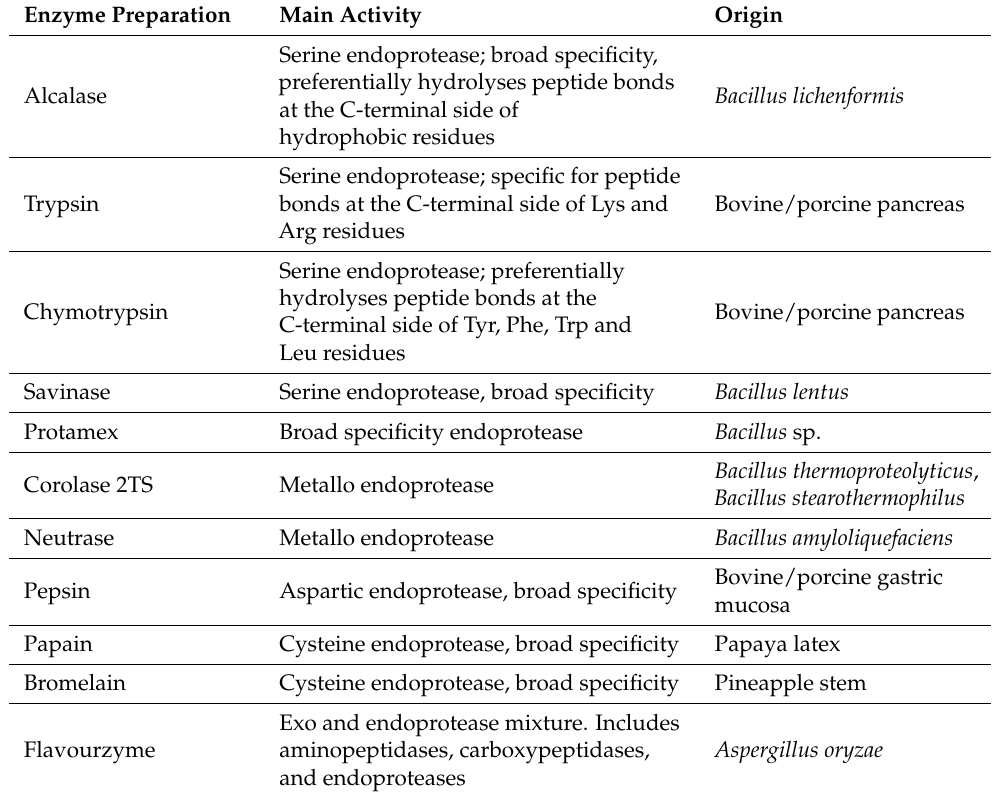
Figure 1. Schematic representation of protease sequence specificity. Adapted from Rawlings and Barrett [31], permission obtained. Table 1. Some commonly used proteases for food protein